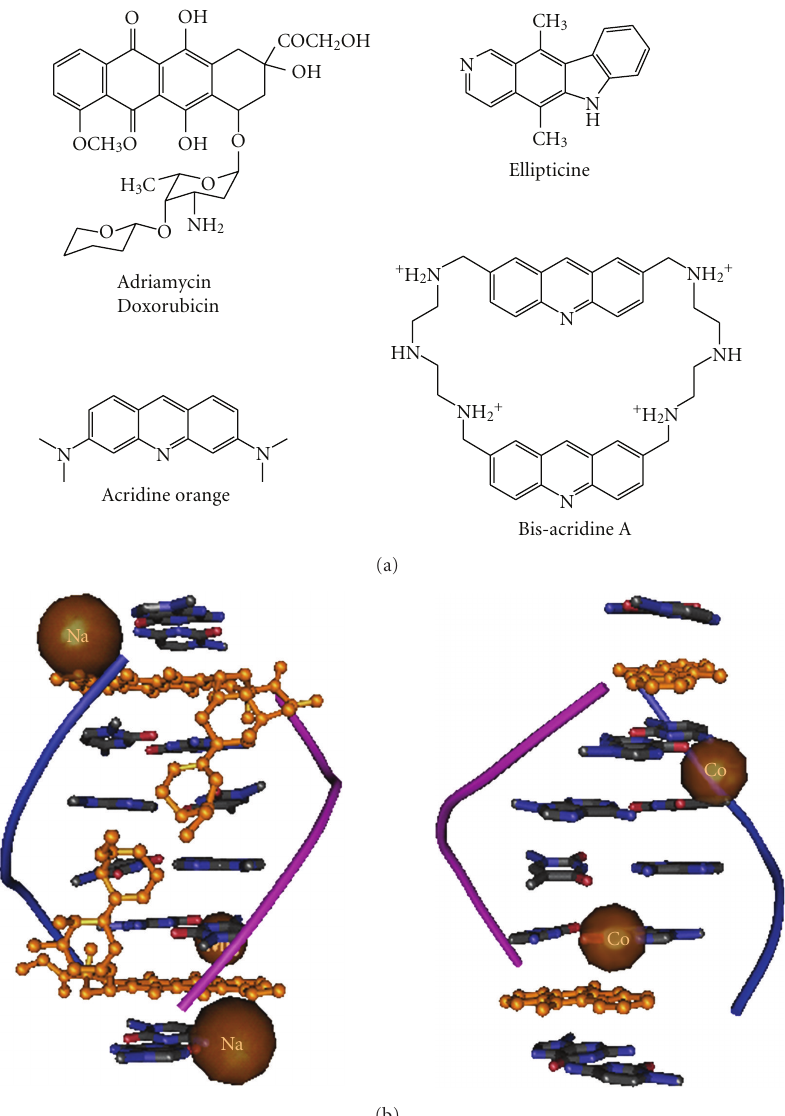
Figure 2: Mono- and bis-intercalating compounds inducing local destabilization of the DNA helix. (a) Structure of the compounds. (b) Three-dimensional organisation of morpholino doxorubicin bound to d(CGTACG) (left panel) and of ellipticine (right panel) intercalated between adjacent base pairs (from crystallographic data [mmdbId:52942] and [mmdbId:52189], respectively, [73,